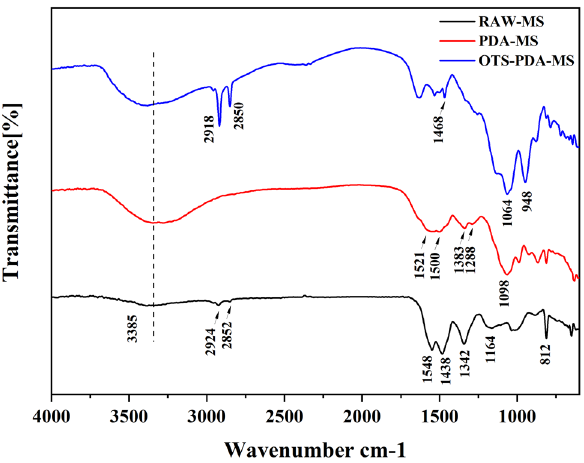
Figure 3. FTIR spectra of raw MS, PDA-MS and